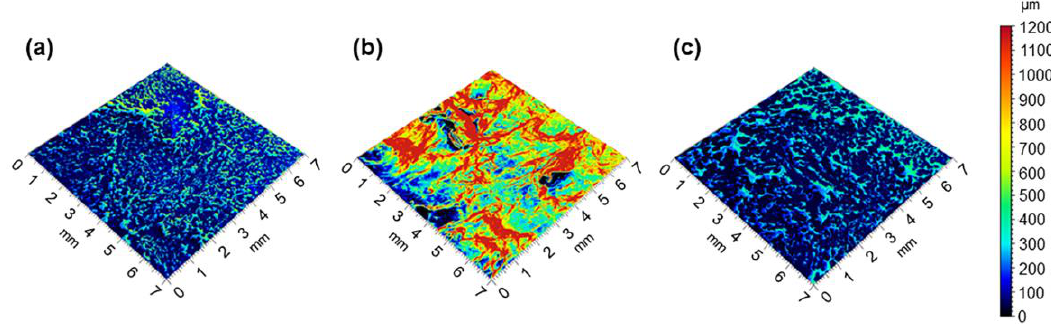
Figure 7. 3D surface reconstruction through SEM image processing of ( a ) epoxy/SWCNT 1 wt%, ( b ) epoxy/SWCNT 4 wt% and ( c ) epoxy/GNP 8 SWCNT 2 4 wt% nanocomposite samples (top surface) after cure.